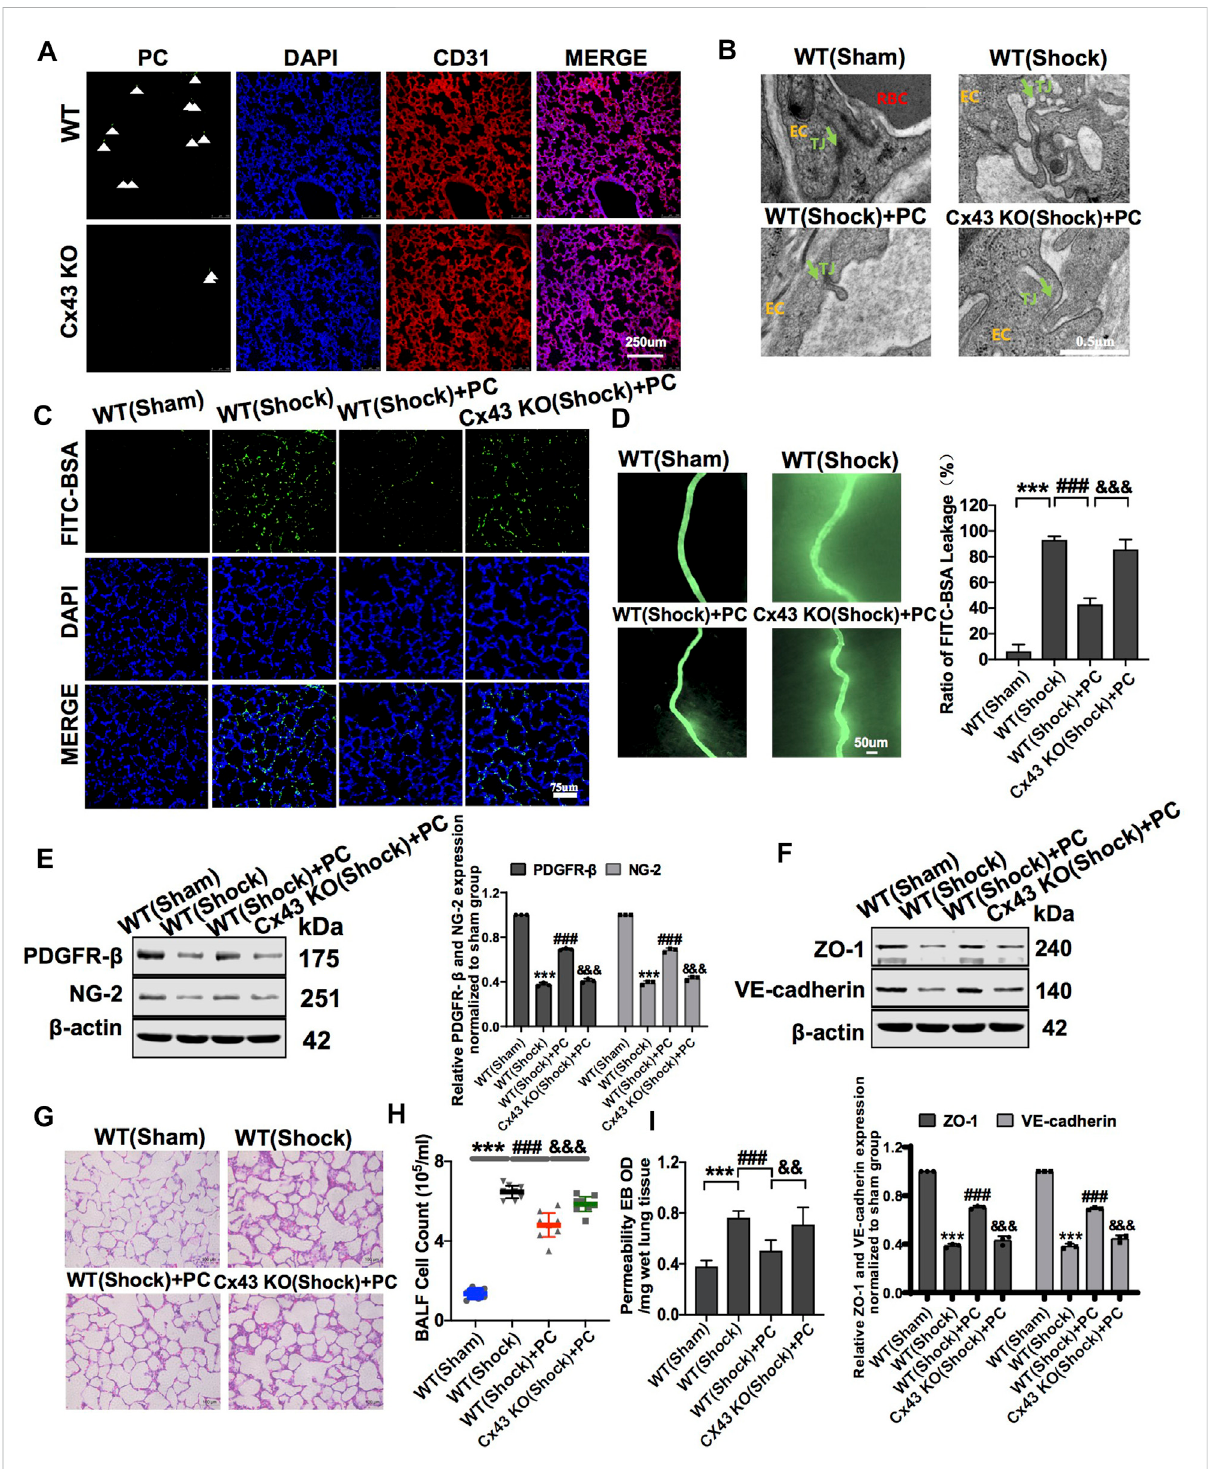
FIGURE 7 KnockdownofCx43inVECsattenuatedtheprotectiveeffectofexogenousPCsonvascularbarrierfunctionandlunginjuryfollowinghemorrhagicshock. (A) ColonizationofexogenousPCsinpulmonaryvesselsobservedusinga fl uorescencemicroscope( n =8). (B) ChangesofthetightjunctionstructureofVECsobserved by TEM ( n = 8). (C) Changes of the pulmonary vascular permeability determined by FITC-BSA ( n = 8). (D) Changes of the mesenteric microvessel permeability determinedbyFITC-BSA( n =8mesentericmicrovesselsfromeightmice). (E) ProteinexpressionofPDGFR- β andNG-2inpulmonaryveinsdeterminedbyWB ( n =12pulmonaryveinsfromthreemice). (F) ProteinexpressionofZO-1andVE-cadherininpulmonaryveinsdeterminedbyWB( n =12pulmonaryveinsfromthree mice). (G) Changes of the in fi ltration of in fl ammatory cells in the alveolar space observed by HE staining ( n = 8). (H) Changes of the amount of cell in BALF after treatment( n =8). (I) ChangesofthepulmonaryvascularpermeabilitydeterminedbyEBexudationinlungtissue( n =8).*** p < 0.001comparedwiththeWT(sham) group(one-wayANOVA). ### p < 0.001comparedwiththeWT(shock)group(one-wayANOVA). &&& p <